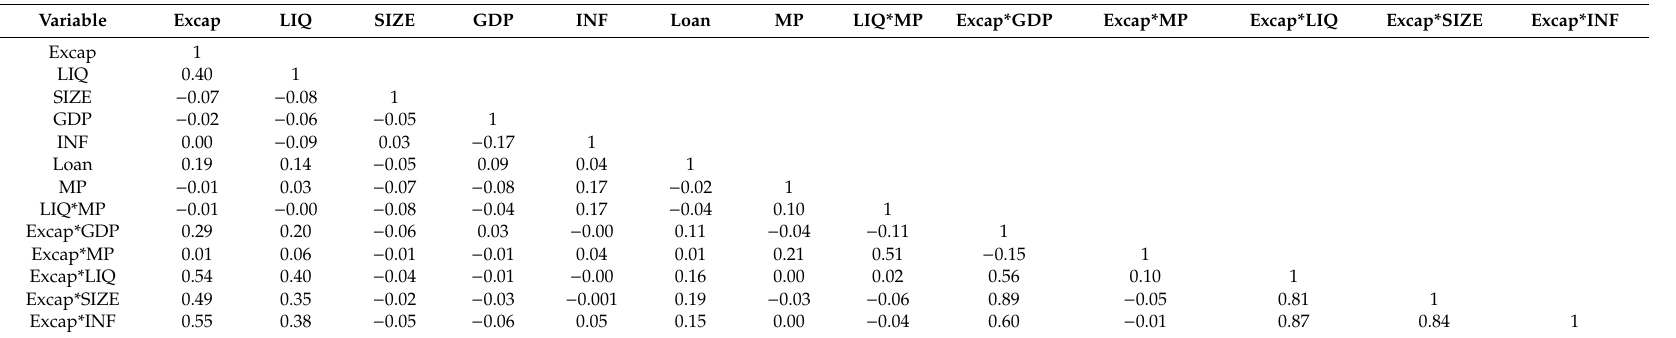
Table A4. Correlation Matrix.